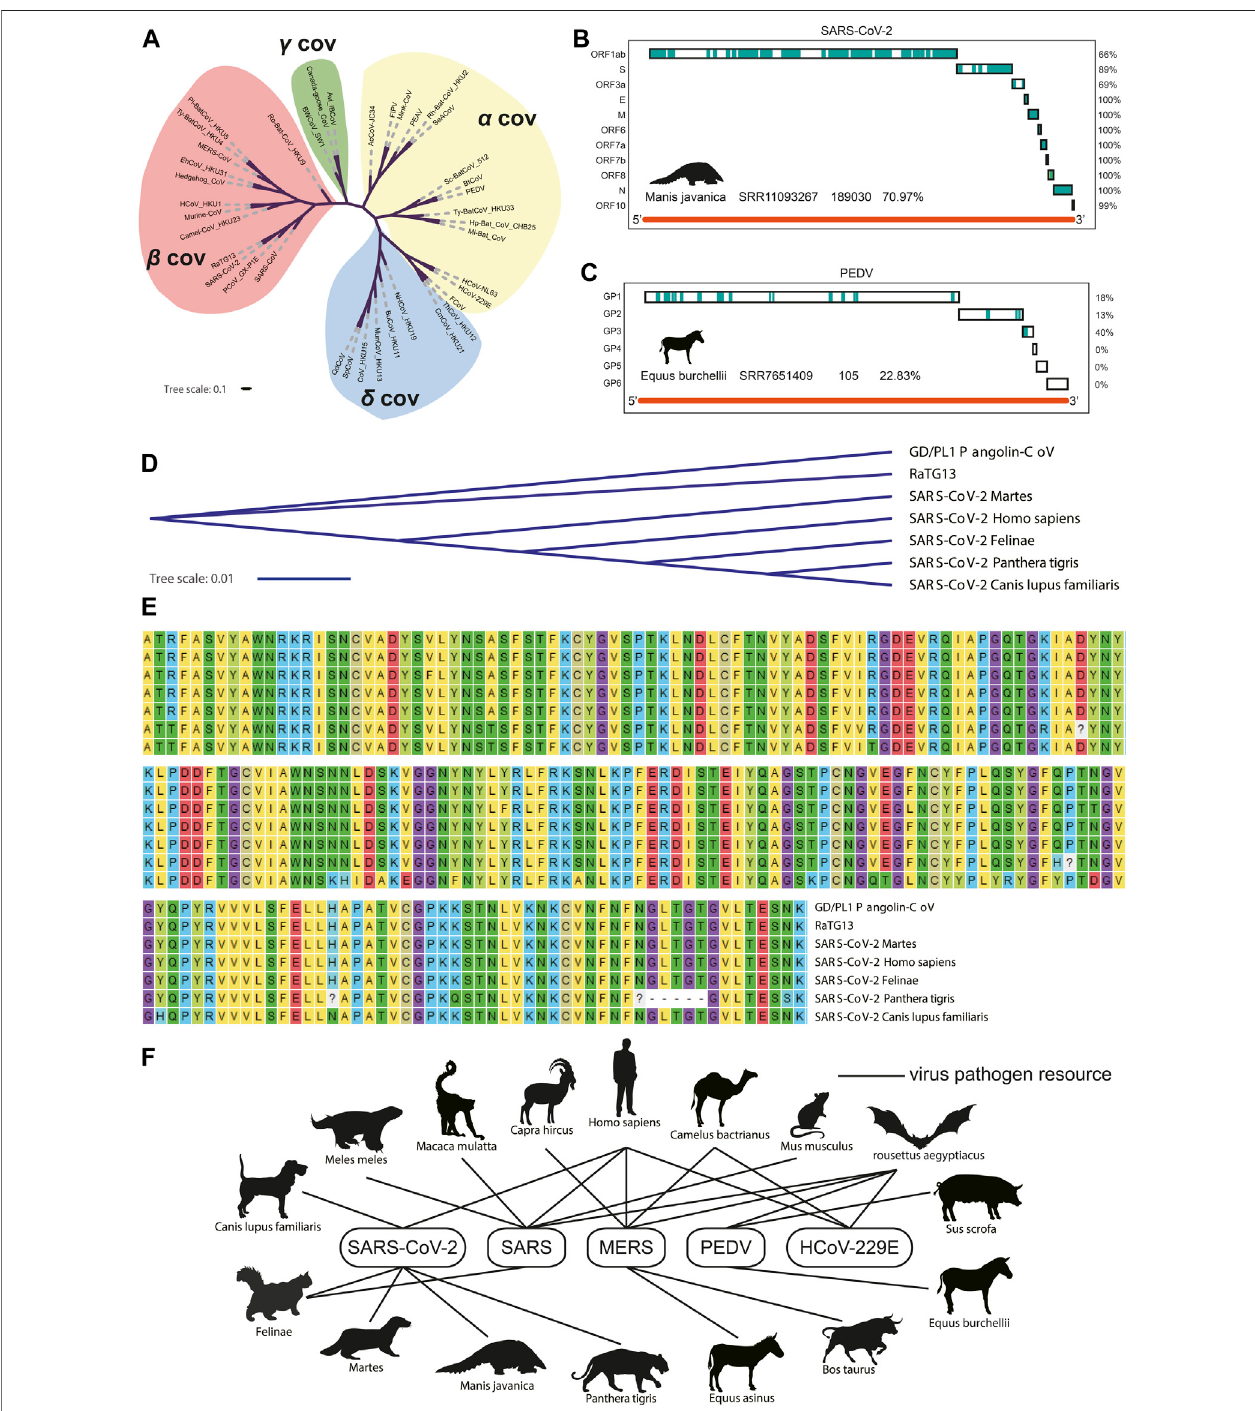
FIGURE 2 | Phylogenetic tree of 38 coronaviruses and potential transmission network. (A) . Phylogenetic tree of 38 coronaviruses. (B) Coverage of fragments isolated from Manis javanica where the blue blocks mean consistent with the SARS-CoV-2 genome (C) Coverage of fragments isolated from Equus burchellii where the blue blocks mean consistent with PEDV genome. (D) Phylogenetic tree of S1 protein. (E) Amino acid sequence alignment results. (F) Potential transmission network of fi ve coronaviruses between different species.